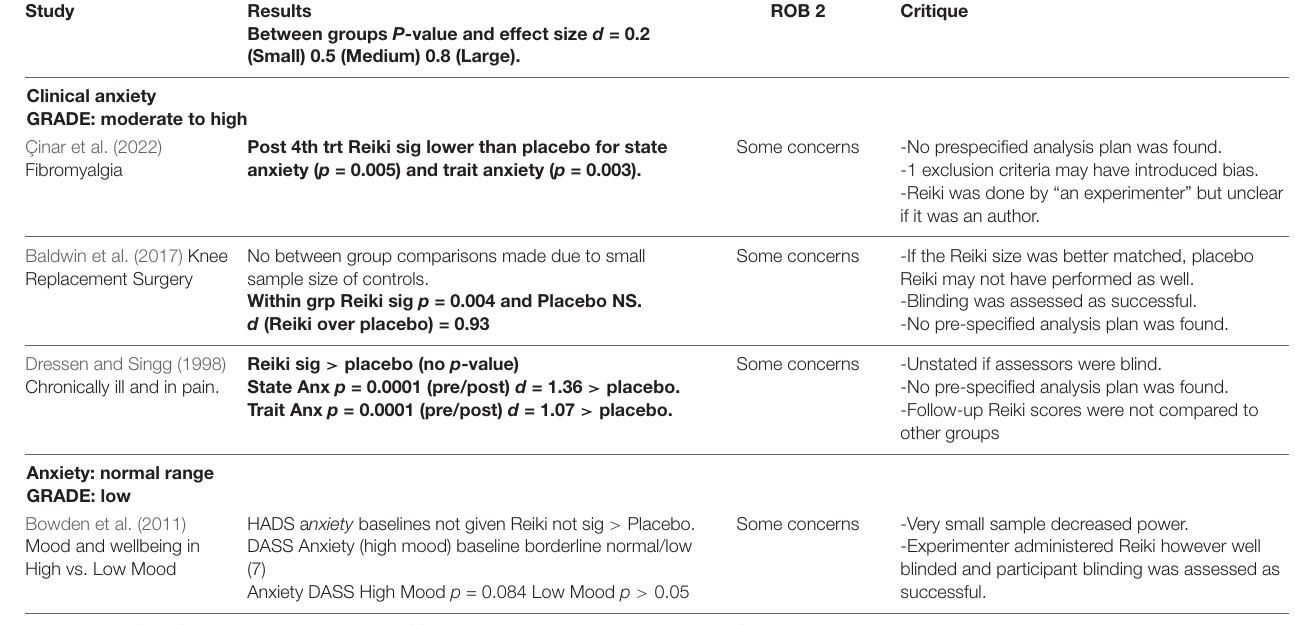
TABLE 1 | Summary of main findings.